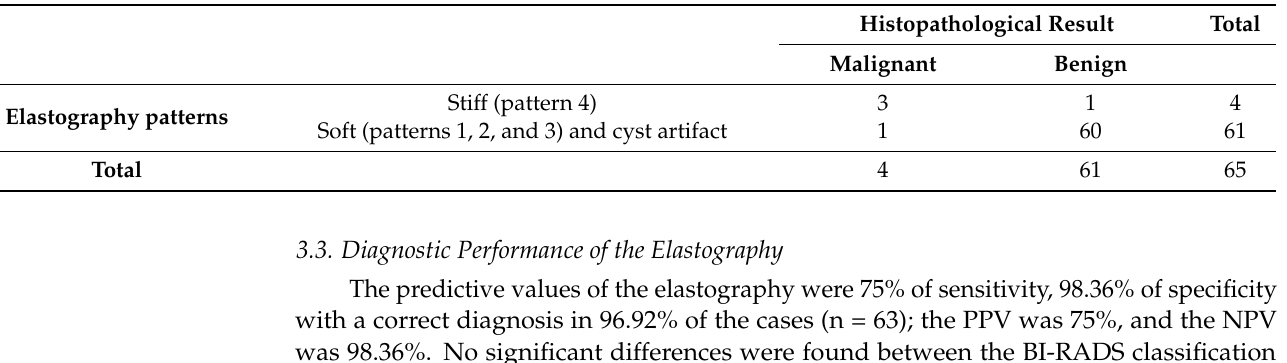
Table 2. Histological correlation with the elastography patterns of the lesions evaluated in the